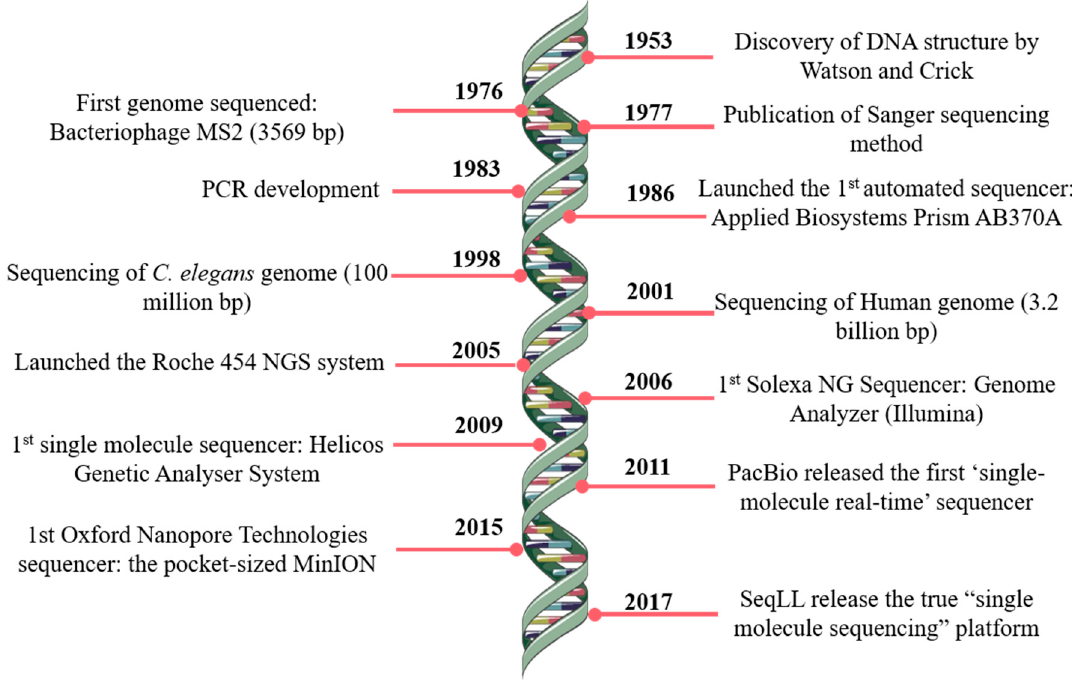
Figure 1. DNA sequencing timeline. Some of the most revolutionary and remarkable events in DNA sequencing. NG—next generation; PCR—polymerase chain reaction; SMS—single molecule sequencing; SeqLL—sequence the lower limit.